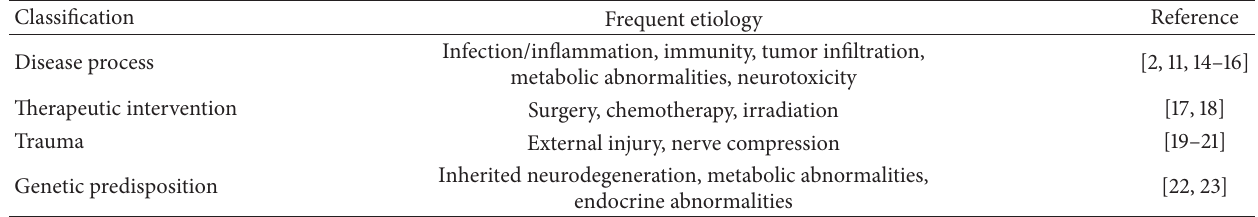
Table 1: The cardinal etiologies of neuropathic